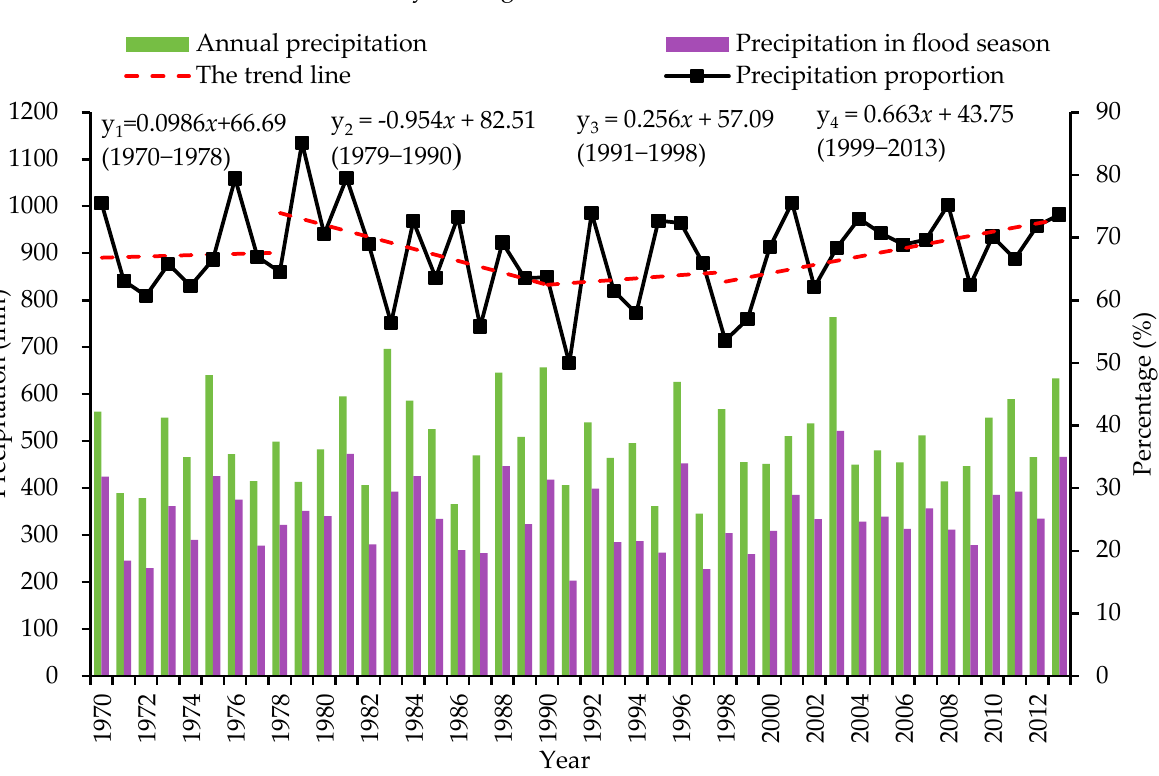
Figure 6. Trend chart of P flood season to the annual precipitation in the JRB, from 1970 to 2015; y 1 : the trend line of the proportion of P flood season to the annual precipitation in the natural period 1970–1978; y 2 : the trend line of the proportion of P flood season to the annual precipitation in the human activity interference period (I) 1979–1990; y 3 : the trend line of the proportion of P flood season to the annual precipitation in the human activity interference period (II) 1991–1998; y 4 : the trend line of the proportion of P flood season to the annual precipitation in the human activity interference period (III) 1999–2013.